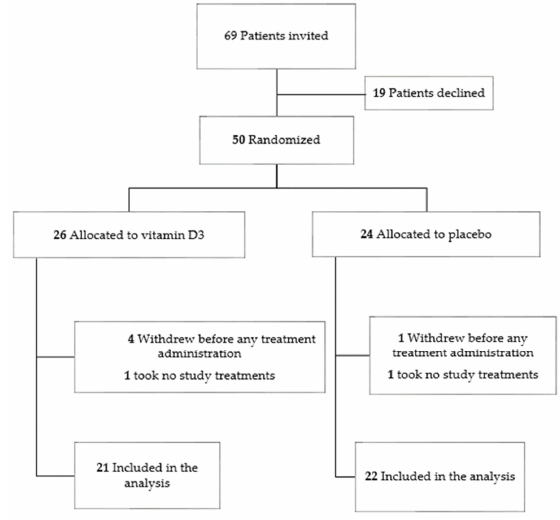
Figure 1. Flow chart of patients included in the study. Table 2. Baseline demographic characteristics.